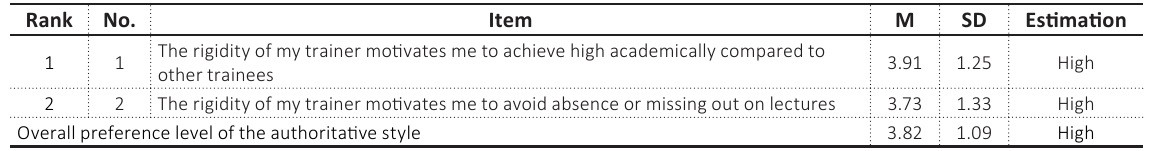
Table 6. Means and standard deviations of respondents’ responses to items measuring the authoritative style in descending order of means